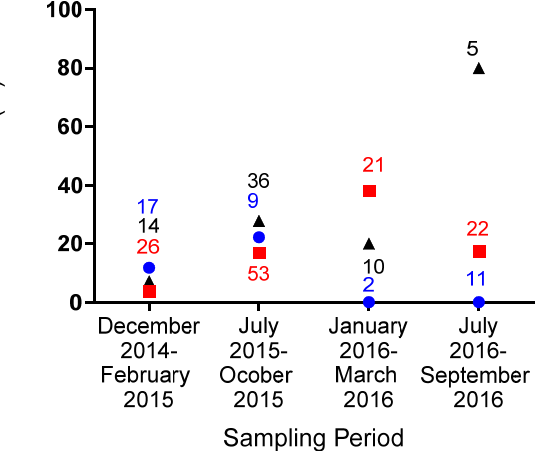
Figure 1. Changes in infection incidence risk over time in groups of wild meerkats receiving targeted